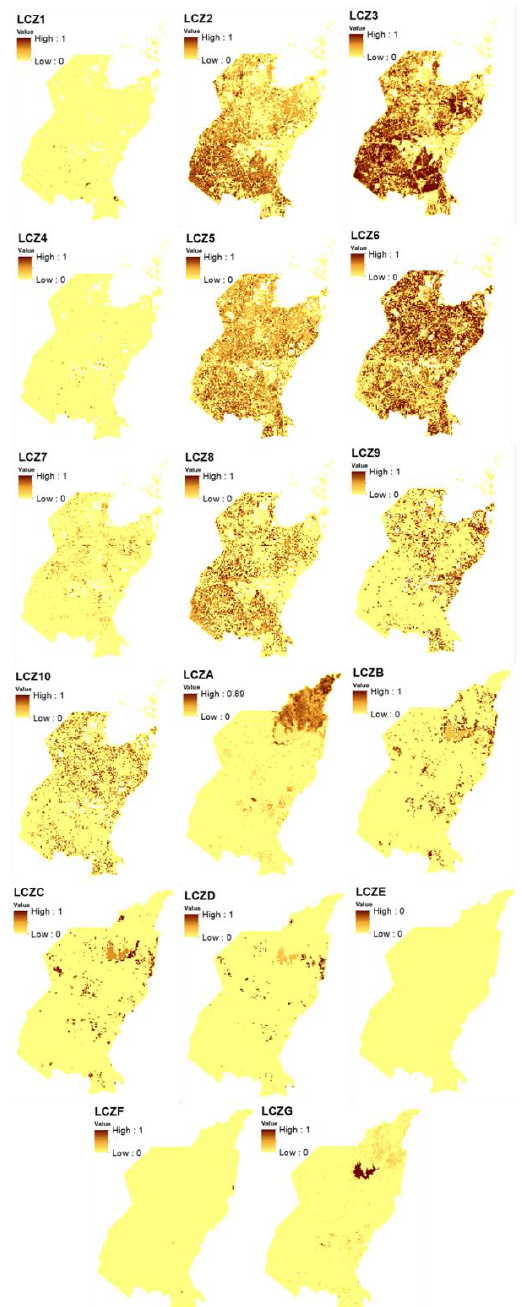
Figure 7. Degree of membership of each pixel to LCZ 1 (Compact high-rise), LCZ 2 (Compact midrise), LCZ 3 (Compact low-rise), LCZ 4 (Open high-rise), LCZ 5 (Open midrise), LCZ 6 (Open low-rise), LCZ 7 (Lightweight low-rise), LCZ 8 (Large low-rise), LCZ 9 (Sparsely built), LCZ 10 (Heavy industry), LCZ A (Dense trees), LCZ B (Scattered trees), LCZ C (Bush, scrub), LCZ D (Low plants), LCZ E (Bare rock or paved), LCZ F ( Bare soil or sand), LCZ G